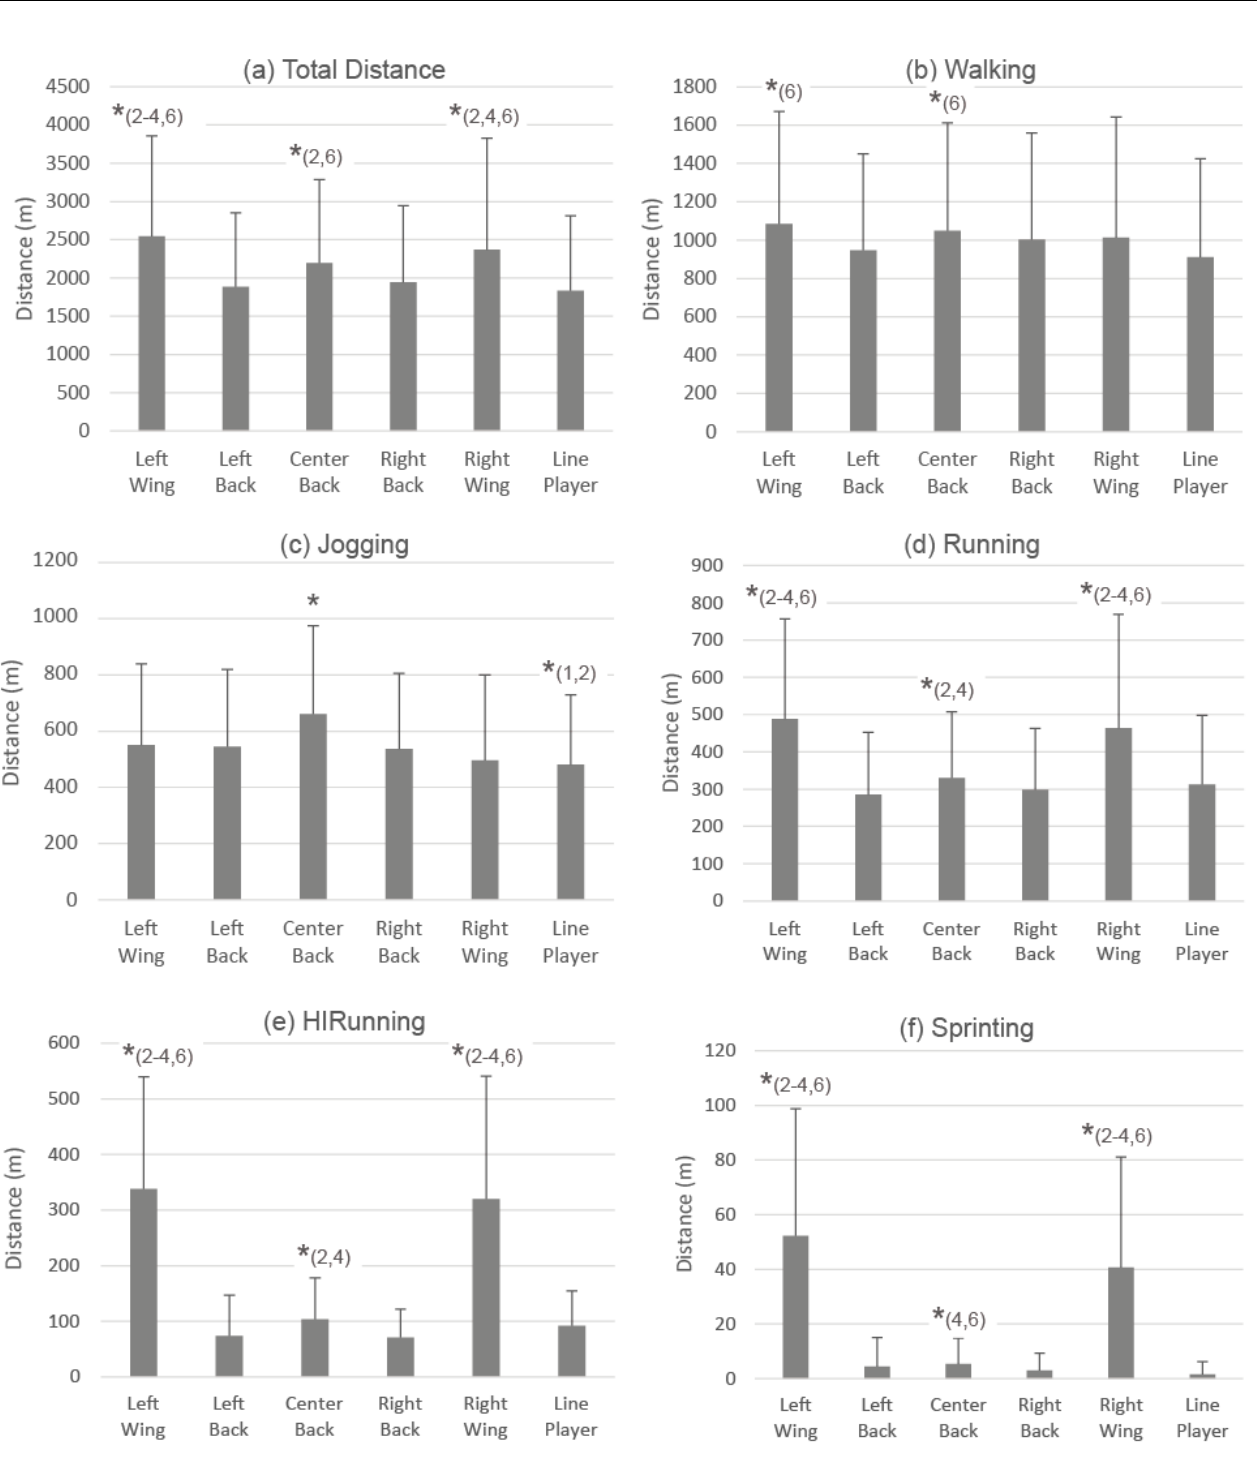
Figure 4. Distance covered in different locomotion categories by position. * Significant differences between positions indicated by numbers: 1 Left wing, 2 Left back, 3 Center back, 4 Right back, 5 Right wing, and 6 Line player.